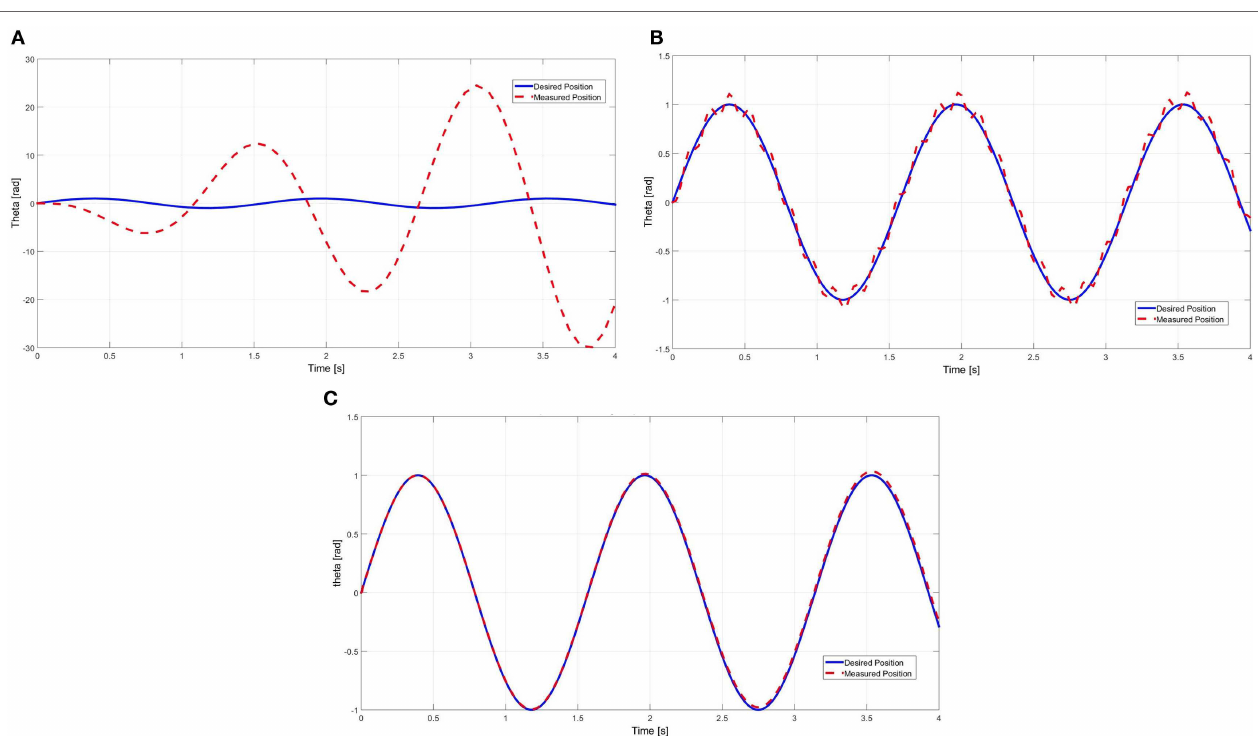
FIGURE 7 | Pitch neck’s rotation with (A) open loop response simulated position tracking, (B) closed loop with applied unity feedback gains, and (C) closed loop response with applied PID gains .